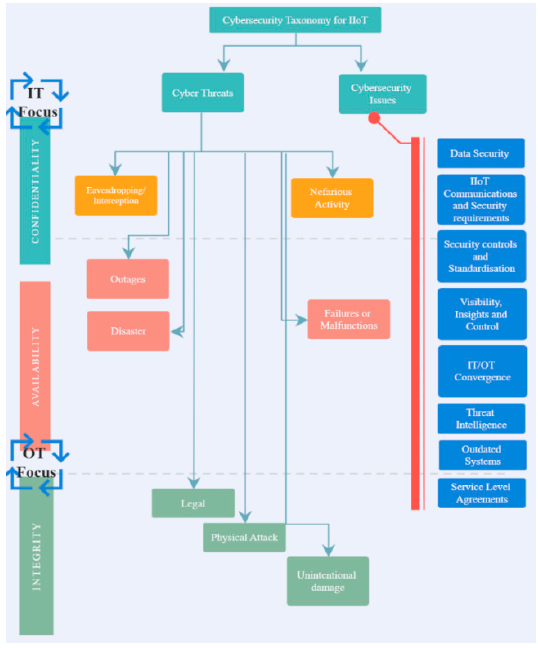
Figure 2. Cybersecurity taxonomy for IIoT.